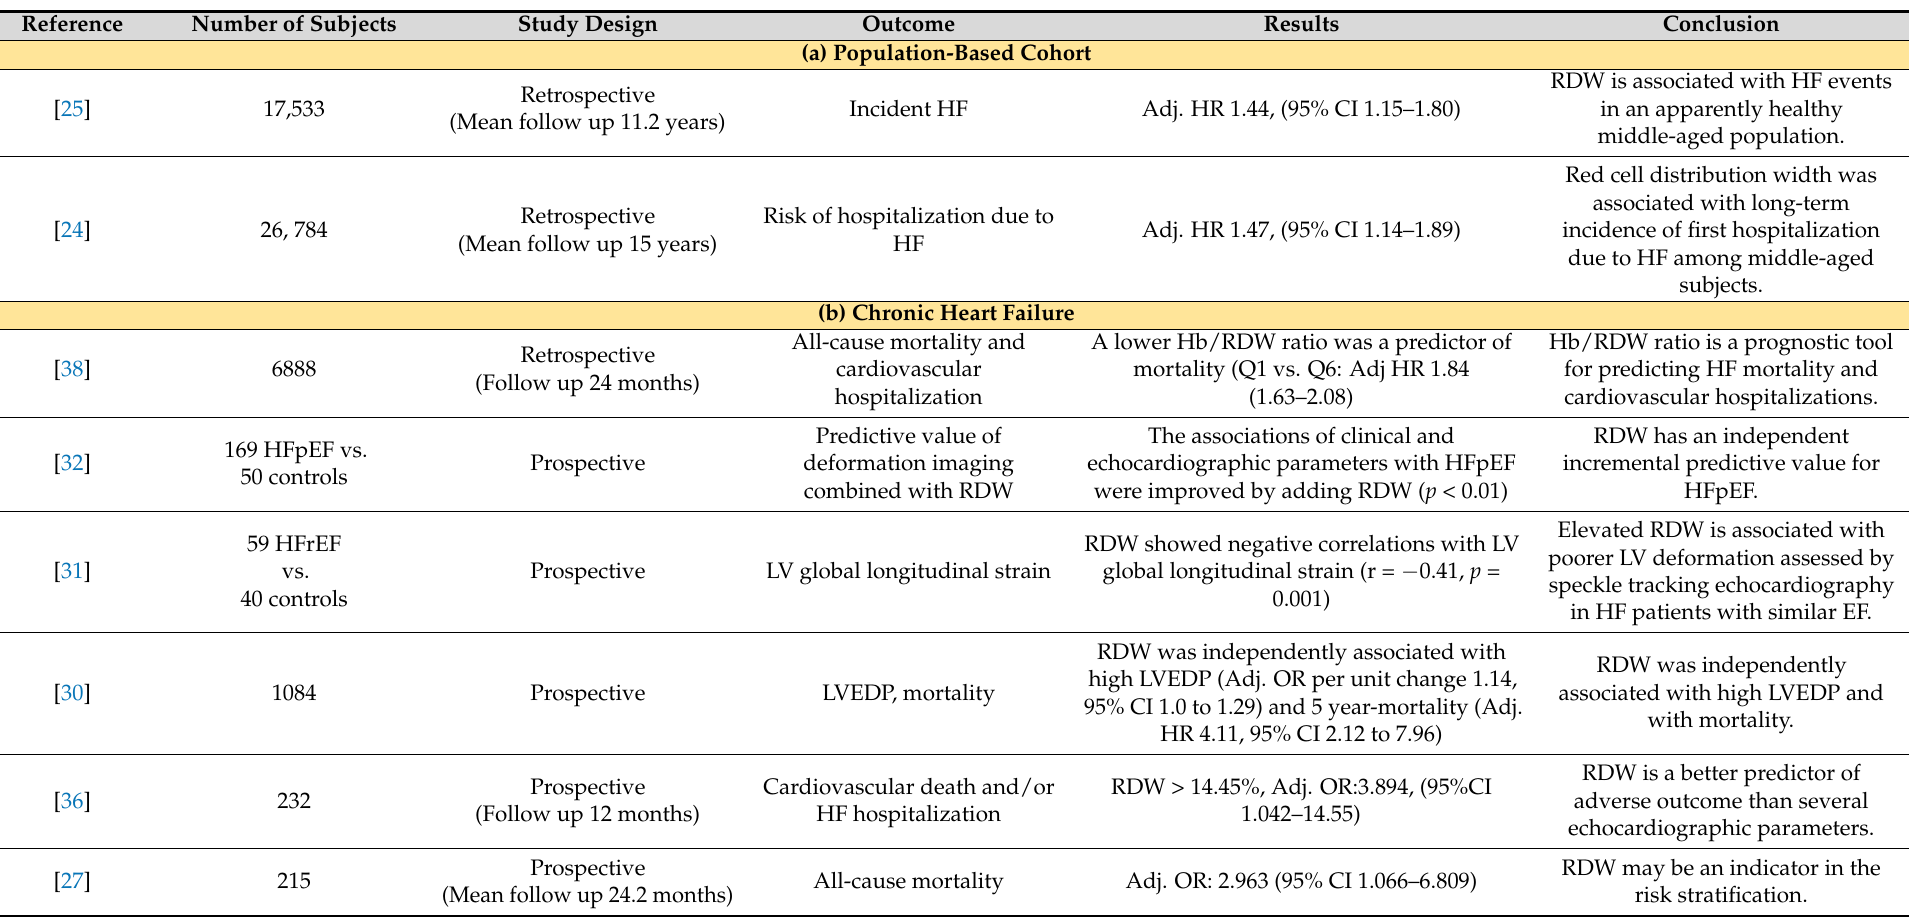
Table 2. Studies examining the prognostic value of RDW in (a) the general population, (b) chronic, (c) acute and (d) advanced heart